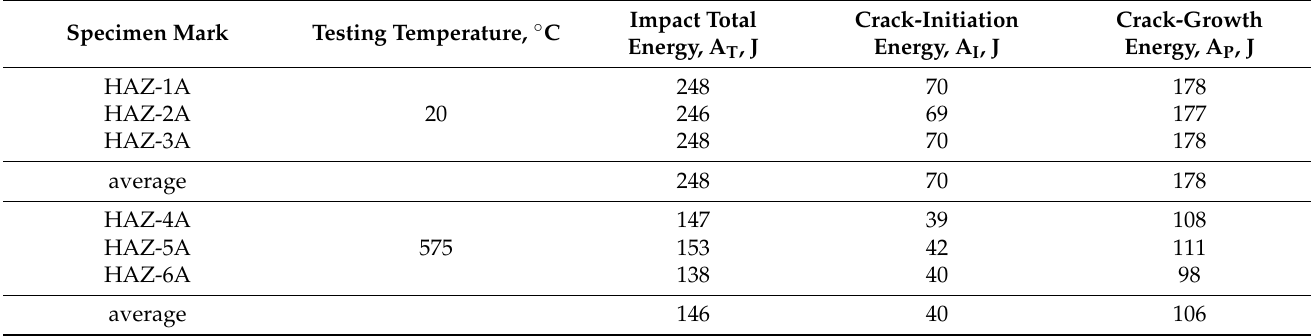
Table 6. Results of Charpy testing—SA 387 Gr. 91 HAZ.